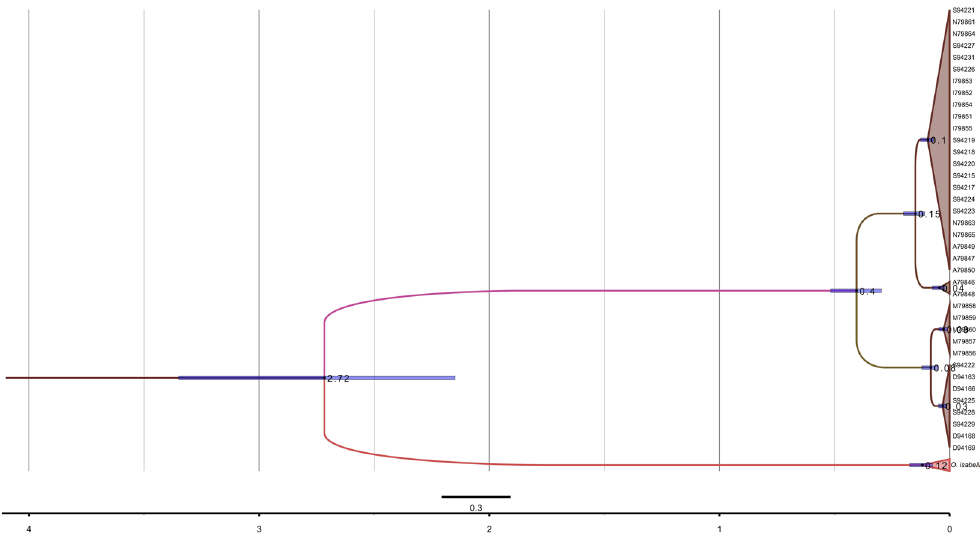
Figure 5. Phylogenetic relationships of O. o. oenanthe (blue), O. o. leucorhoa (green) O. seebohmi and O. isabellina based on the mitogenome. The values indicate the split time calculated by BEAST 1.8. The Bayesian posterior probabilities of all the nodes are 1. The blue bars show 95% highest posterior density (HPD) of divergence